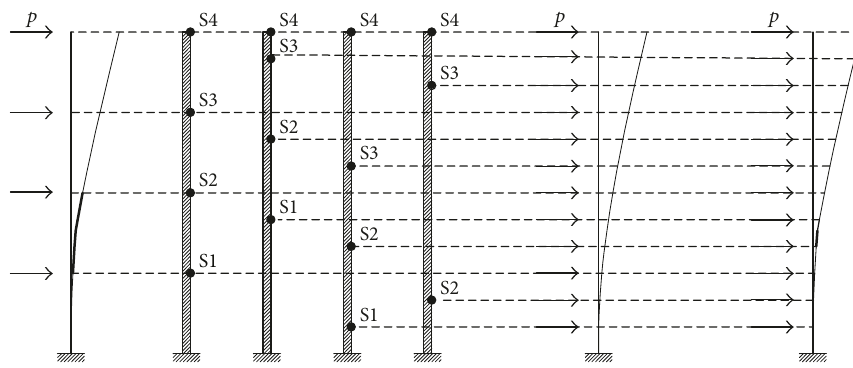
Figure 6: Reduction of the discretization interval through repeated tests.